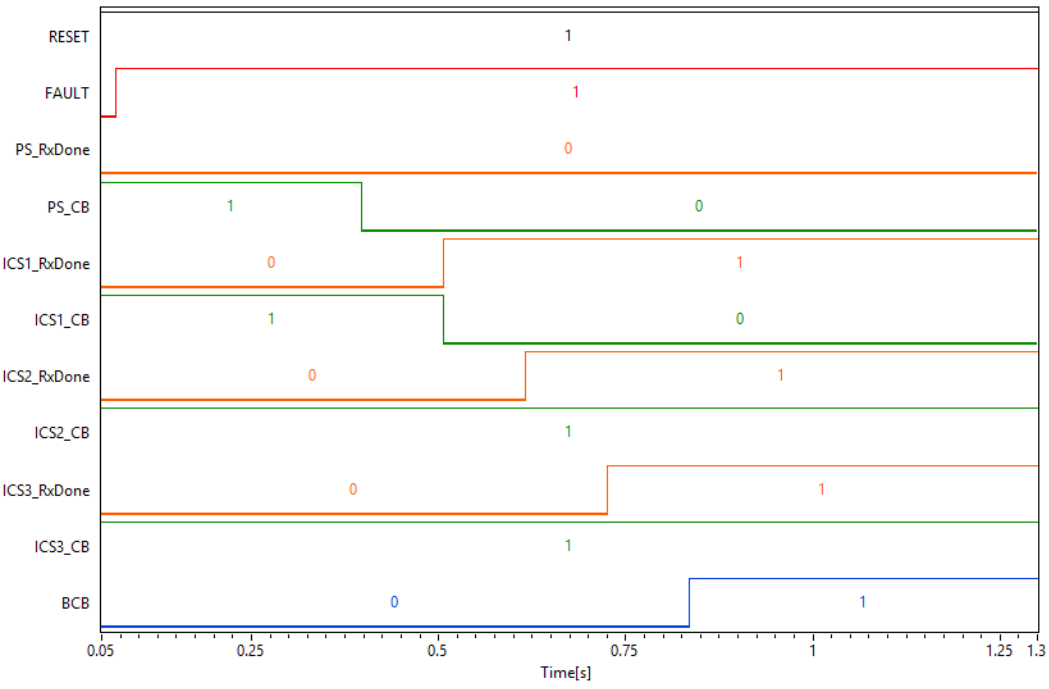
Figure 18. Digital signals acquired during the fault 67N.S1 between SR and PR1, with a LoRa T packet of 103.42 ms.